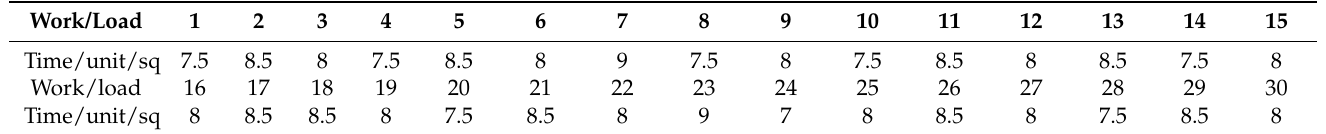
Table 2. Monolithic walls—time consumption/wall (unit 13.1 m 2 )/squad